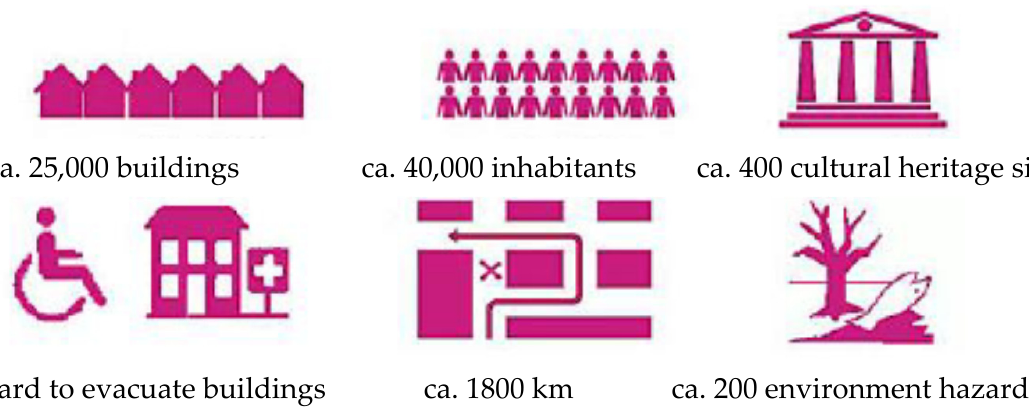
Figure 2. Indicators for significant flood risk areas in Finland (Based on FEI [42]).